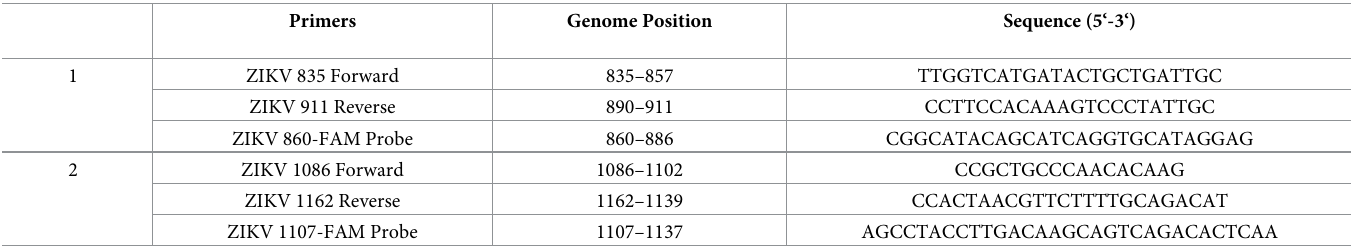
Table 5. Primer/Probe sets for the detection of ZIKV by one step